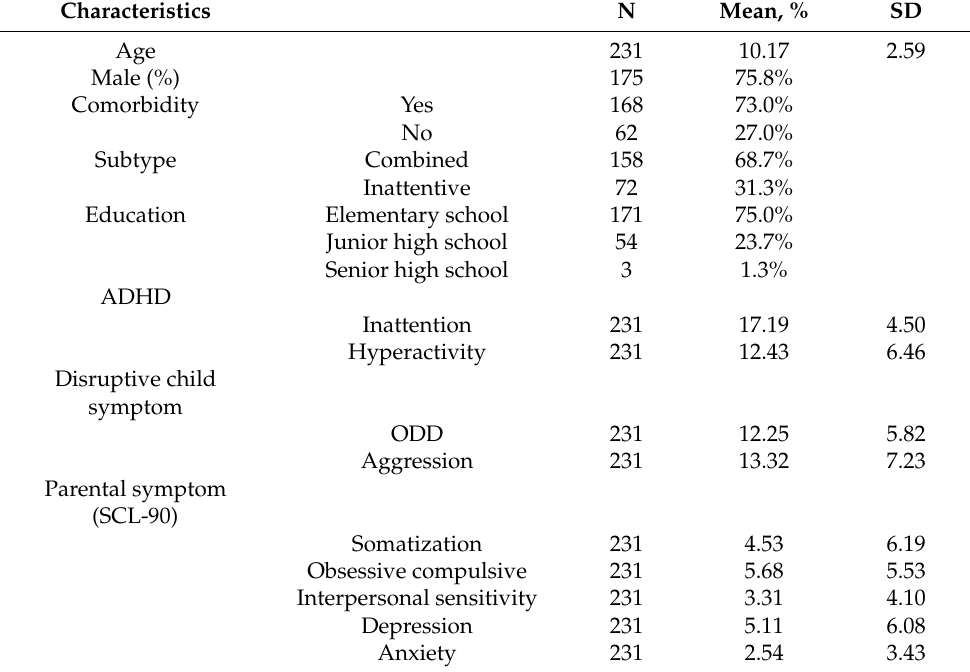
Table 1. Sample characteristics of study measures.